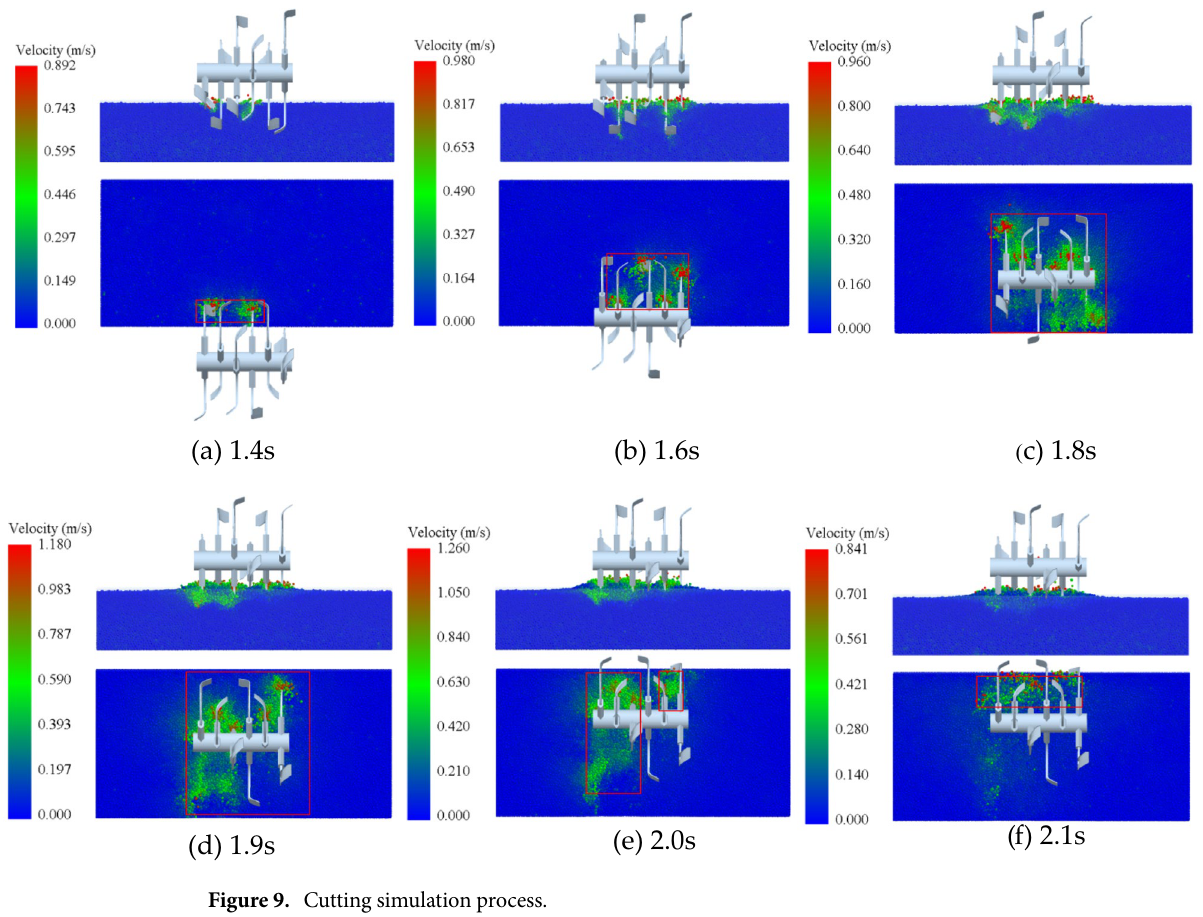
Figure 9. Cutting simulation